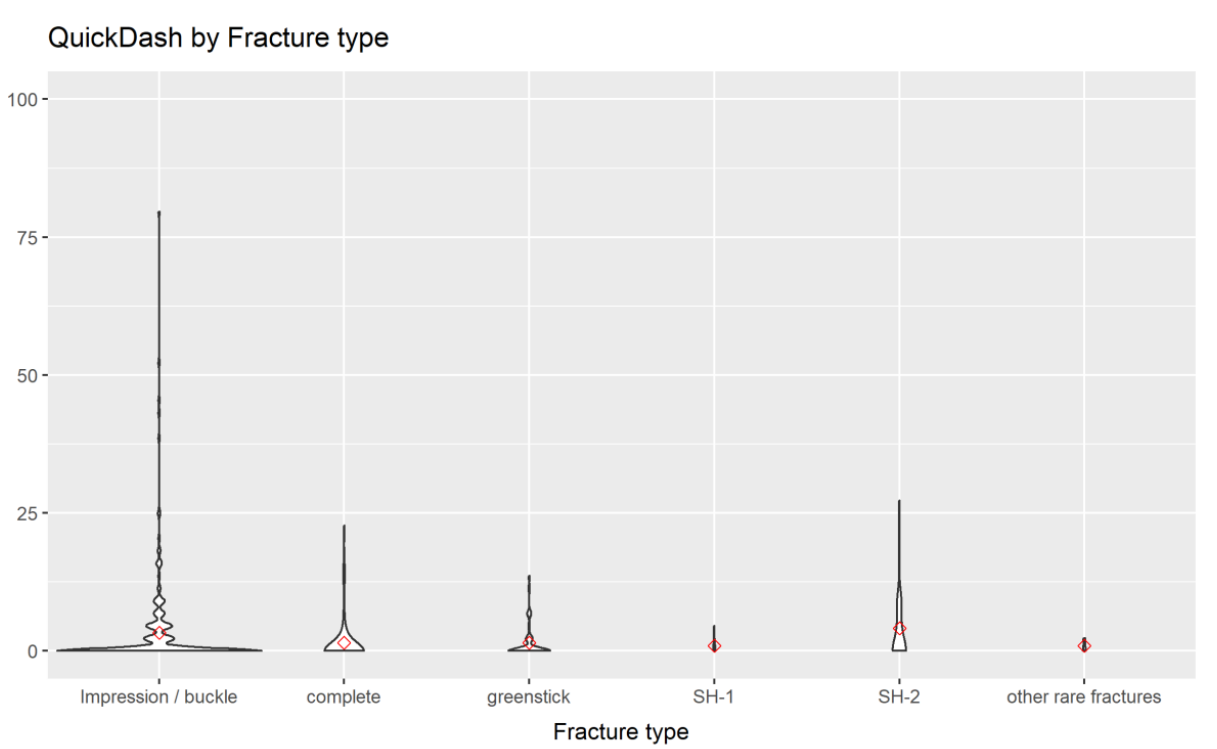
Figure 3. Peds-QL physical function at follow-up by fracture type of the radius.